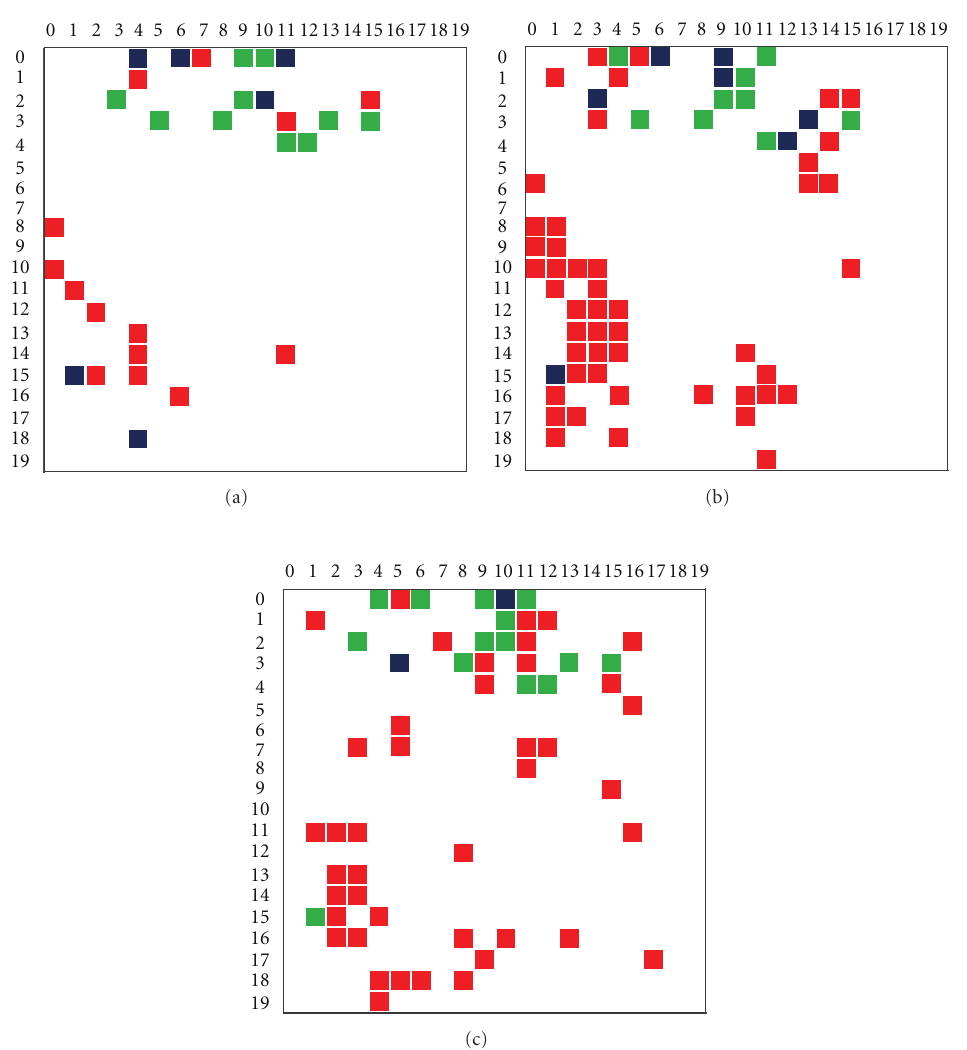
Figure 3: Self-organizing map (SOM) projection of MHC I stabilizing peptides. The SOM was trained with 100,603 octapeptides (603 peptides with known H-2K b binding a ffi nity and 100,000 octamer sequences randomly designed according to the amino acid frequency of M. musculus proteins). Neurons are colored according to the MHC I stabilizing ability of the octapeptides (red: nonstabilizing; blue: mixed; green: stabilizing). (a) Projection of the known 251 stabilizing octapeptides and 24 nonstabilizing octapeptides with amino acid sequences corresponding to the canonical motif in all three positions. (b) Projection of the known 251 stabilizing octapeptides and 93 nonstabilizing octapeptides with amino acid sequences corresponding to the canonical motif in two positions. (c) Projection of the known 251 stabilizing octapeptides and 59 nonstabilizing octapeptides with amino acid sequences corresponding to the canonical motif in only one position.